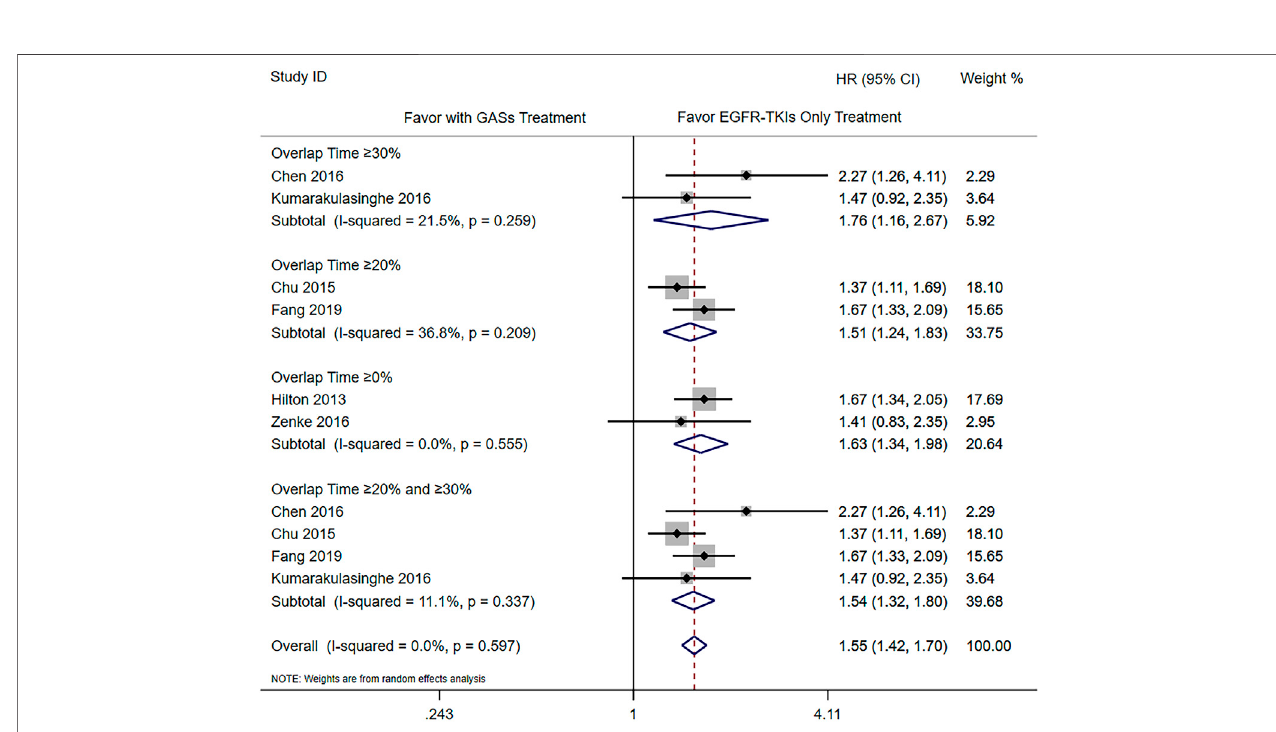
FIGURE 4 | In fl uence of concomitant use of GASs in different overlap time on the OS.